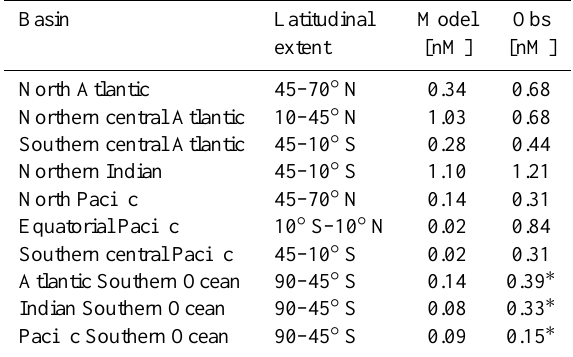
Table 2. Modelled mean surface iron concentrations (0–100m) in the different ocean basins shown in Fig. 3. Observed values are from Moore and Braucher (2008), except those marked with ∗ , which are from Tagliabue et al. (2012), Table 2. The latter is the mean of the values given for the Antarctic and Subantarctic